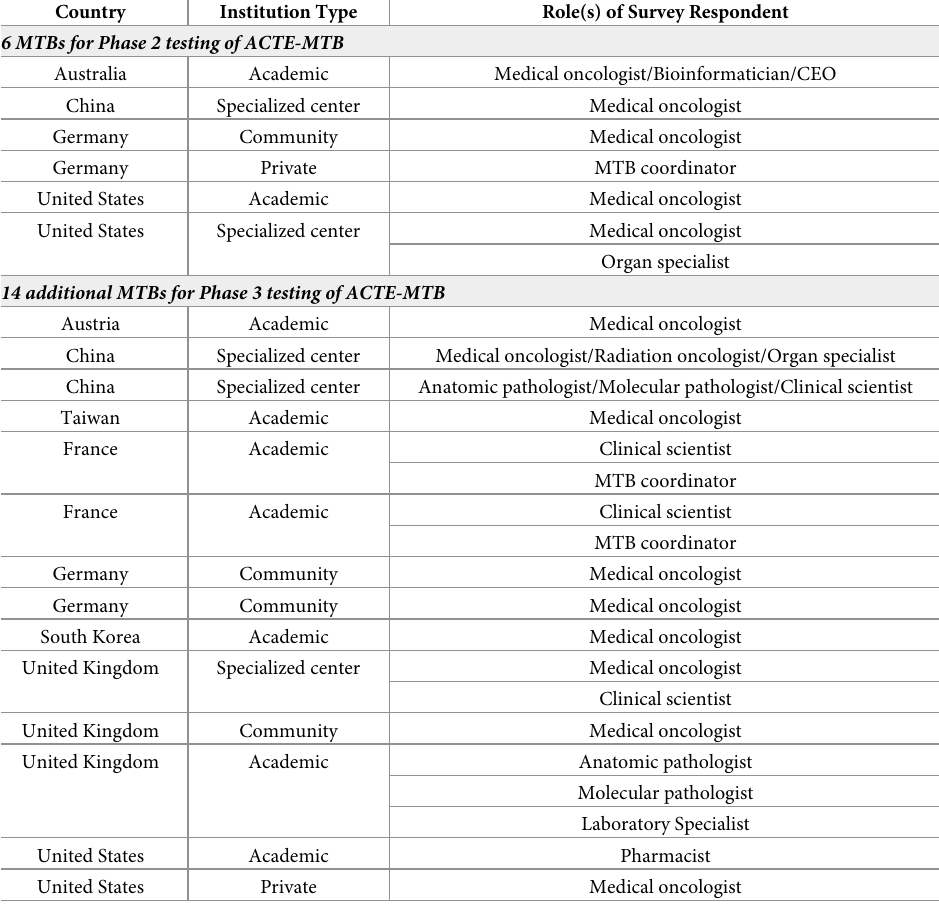
Table 2. MTB demographics and participation in validity testing of the ACTE-MTB maturity